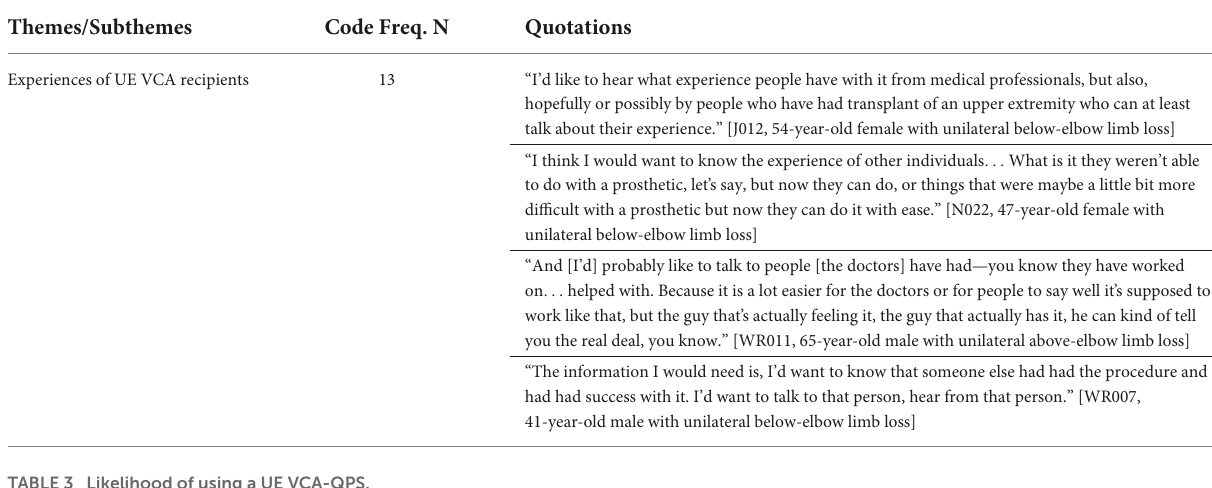
TABLE 3 Likelihood of using a UE